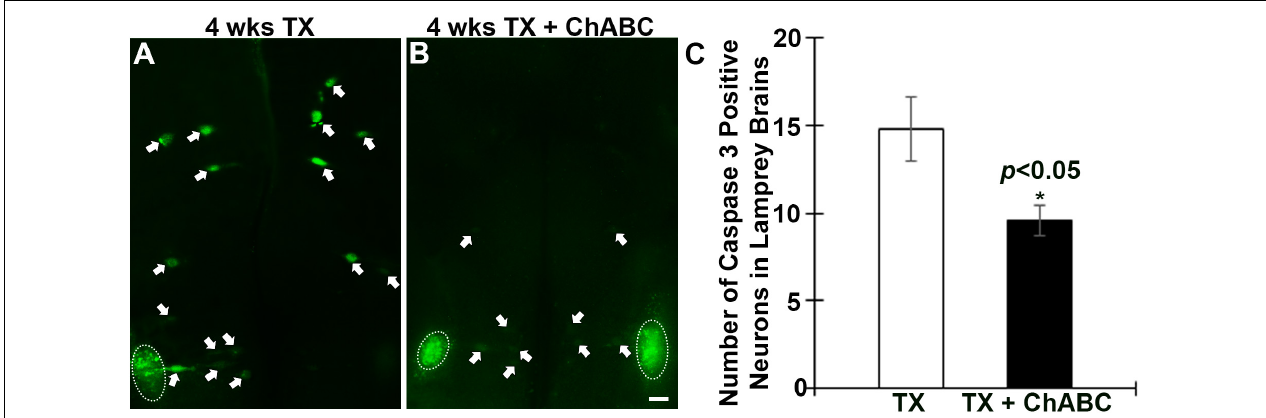
FIGURE 4 | Active caspase 3 in RS neurons is reduced by ChABC at 4 weeks post-TX. Spinal cords were transected at the 5th gill with or without ChABC, and allowed to recover for 4 weeks. ChABC reduced the number of caspase 3-positive RS neurons at 4 week post-TX significantly ( A vs. B ). (C) A graph showing the number of caspase 3-positive identified RS neurons per brain at 4 weeks post-TX with or without ChABC. Arrows point to the active caspase 3 positive RS neurons, and circles outline cranial motor nuclei, whose neurons rapidly become caspase positive when they are axotomized during brain dissection. * p < 0.05, n = 5 lampreys per group. Error bars: SEM. Scale bar: 100 µ